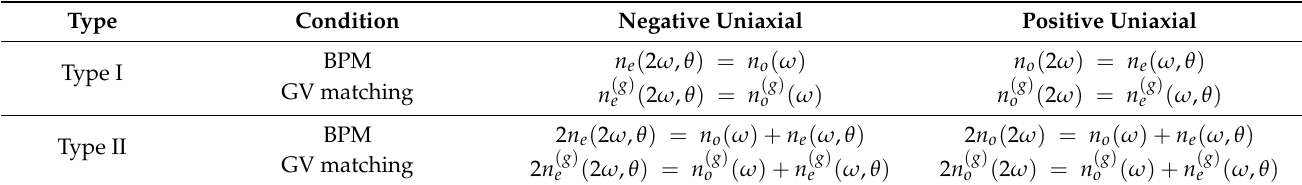
Table 2. The BPM and GV matching conditions for broadband SHG in uniaxial